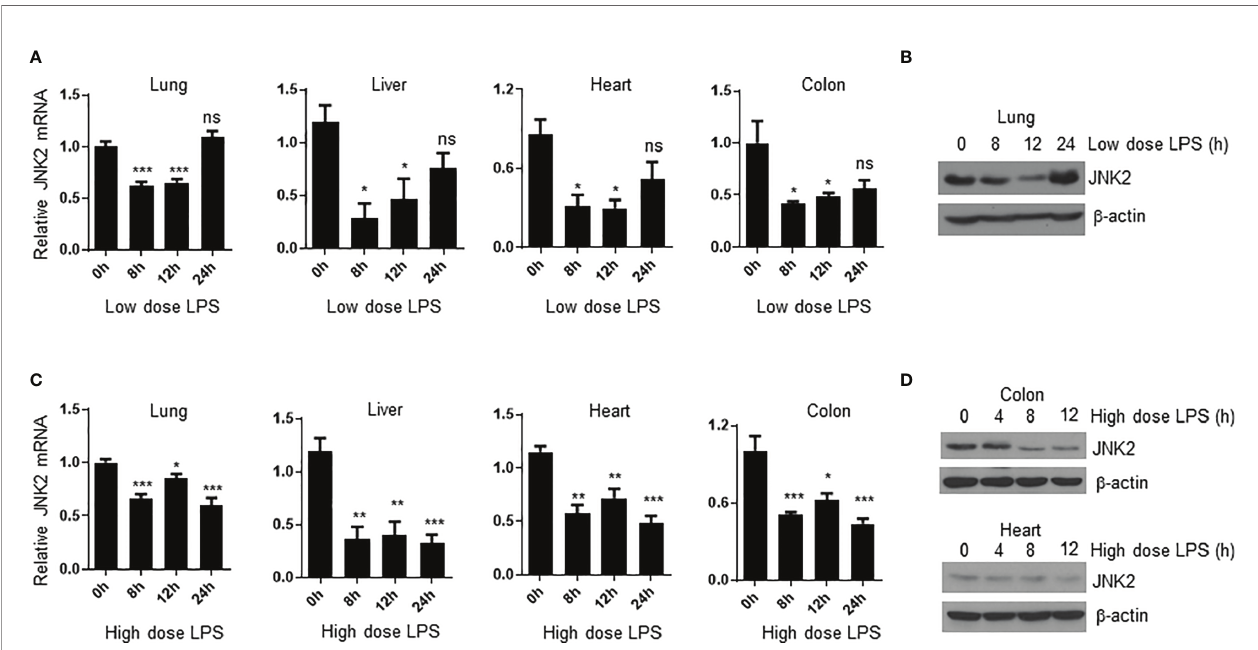
FIGURE 4 | JNK2 mRNA levels are negatively correlated with disease severity during sepsis. (A) JNK2 mRNA expression in different organs of wild-type mice treated with low dose LPS for different times as indicated. (B) JNK2 protein expression in whole lung homogenates of wild-type mice treated with low dose LPS for different times as indicated. (C) JNK2 mRNA expression in different organs of wild-type mice treated with high dose LPS for different times as indicated. (D) JNK2 protein expression in whole colon or heart homogenates of wild-type mice treated with high dose LPS for different times as indicated. In (A, C) , N=3-